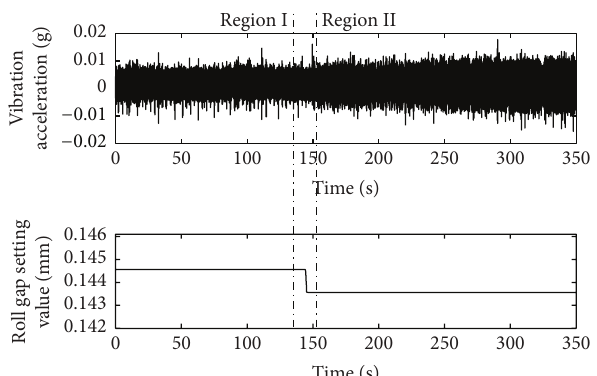
Figure 20: Dynamic rolling experiment under different reduction ratios.